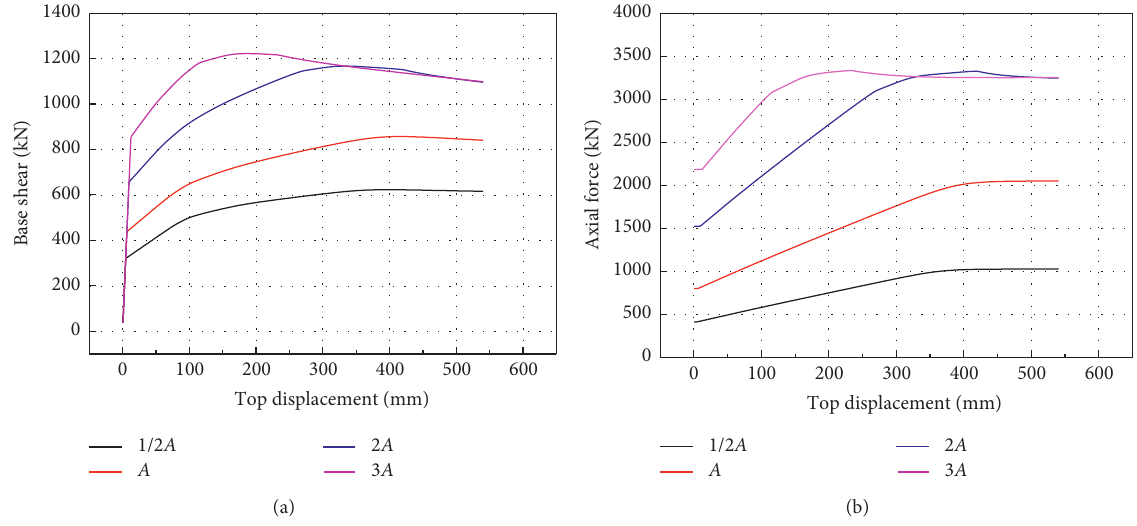
Figure 27: (a) Pushover curve of base shear versus top displacement; (b) pushover curve of axial force versus top displacement.